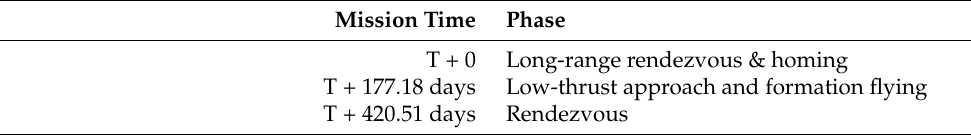
Table 6. Phases timeline for the JWST servicing